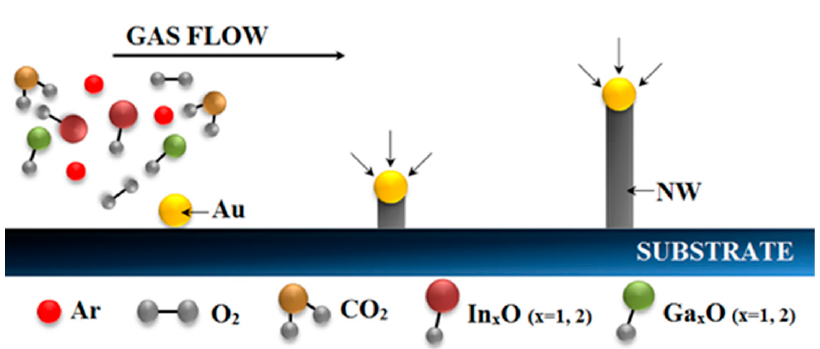
Figure 1. Sketch of the VLS growth process showing the nucleation and the progressive growth of the NWs via the incorporation of the materials in the catalytic gold droplet.